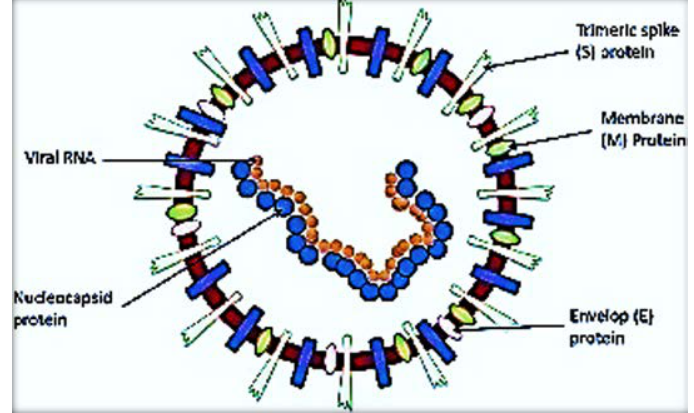
different small compounds and molecules have also been reported against virus infection. Amiodarone gets accumulated in the acidic organelles. Vacuoles on exposure to amiodarone shows alteration in intracellular organelles especially enlargement of late endosomes. In in-vitro